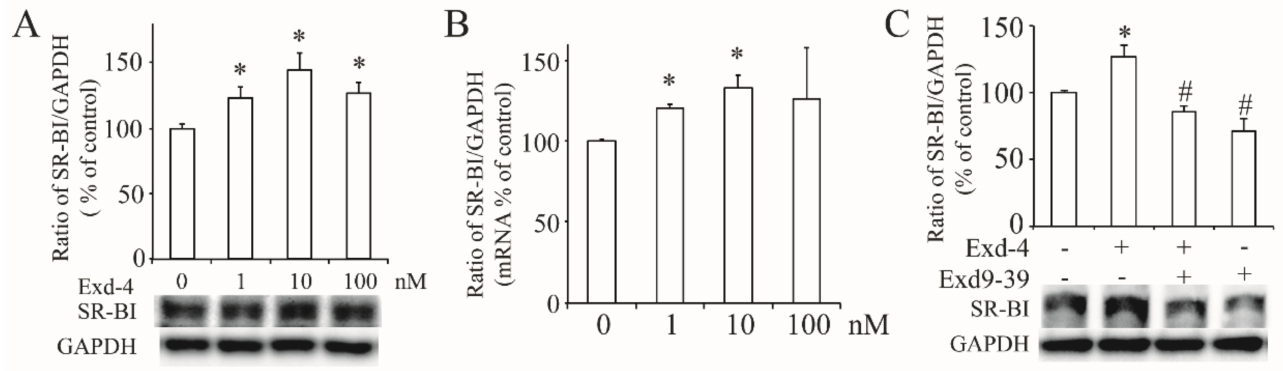
Figure 2. Exendin-4 increased the expression of hSR-BI/CLA-1 via GLP-1 receptor in HUVECs. ( A ) The protein expression of hSR-BI/CLA-1 in HUVECs treated with exendin-4 at varying doses (0~100 nM) for 24 h. ( B ) The mRNA level of hSR-BI/CLA-1 in HUVECs treated with exendin-4 at varying doses (0~100 nM) for 24 h. ( C ) The protein expression of hSR-BI/CLA-1 in HUVECs treated with exendin-4 at 10 nM together with or without exnendin9-39 for 24 h. A graph showing the mean ± SEM (n = 3) of separate experiments for each treatment group is included. The ratio of hSR-BI/CLA-1 to GAPDH is shown as percent of control. * p < 0.05 compared with control; # p < 0.05 compared with